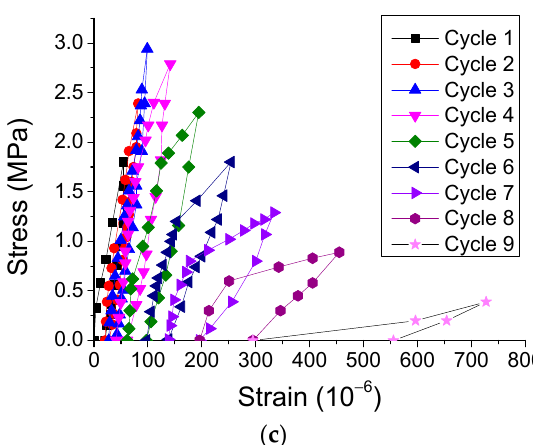
Figure 13. Typical experimental results of stress-strain curves of SCC considering the cycle number. ( a ) Sample C-Prism 9 in compressive case, ( b ) Sample C-Prism 10 in compressive case, and ( c ) Sample T-Prism 6 in direct tensile case.